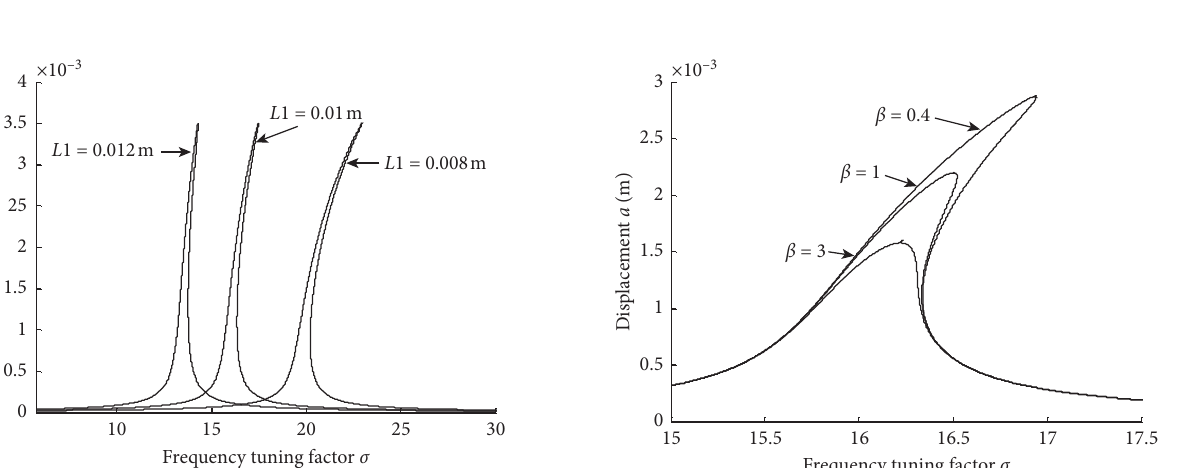
Figure 5: The influence of nonlinear friction coefficient on am- plitude frequency characteristic